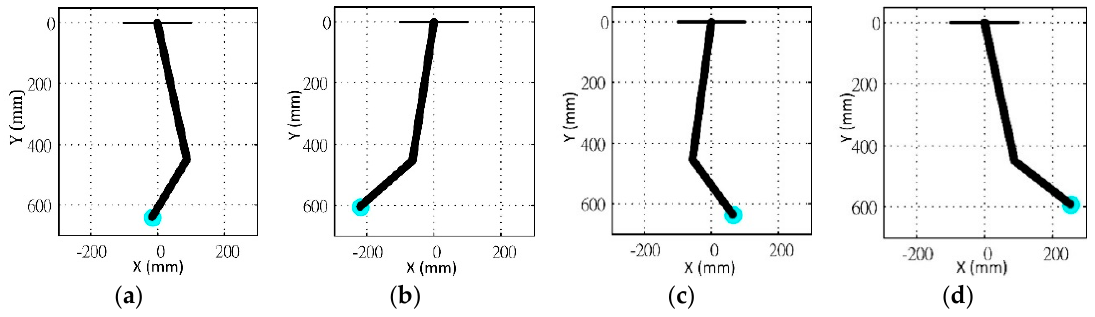
Figure 6. Illustrative motion sequence ( a – d ) of the two-link model with the closed-loop control method.